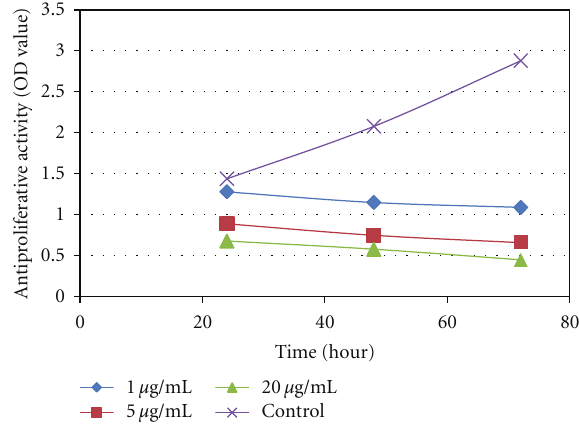
Figure 6: E ff ect of pyranocycloartobiloxanthone A ( 1 ) on the proliferation of MCF7 cells in vitro . After treatment with 1 μ g/mL, 5 μ g/mL (IC 50 based on MTT results) and 20 μ g/mL for 24, 48, and 72 hours cellular proliferation of MCF7 cells was assayed using BrdU incorporation